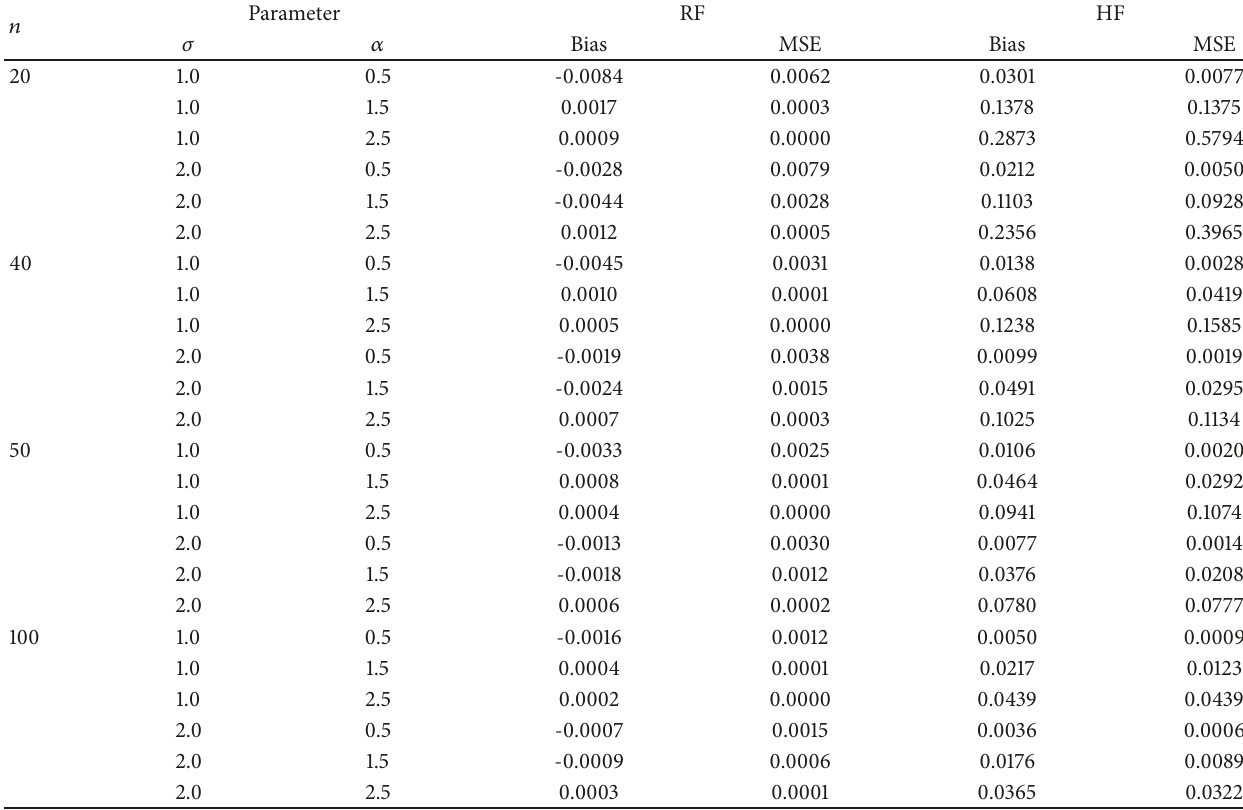
Table 5: Bias and MSE of reliability and hazard functions obtained from different values of 𝑛 , 𝜎 , and 𝛼 . 𝑛